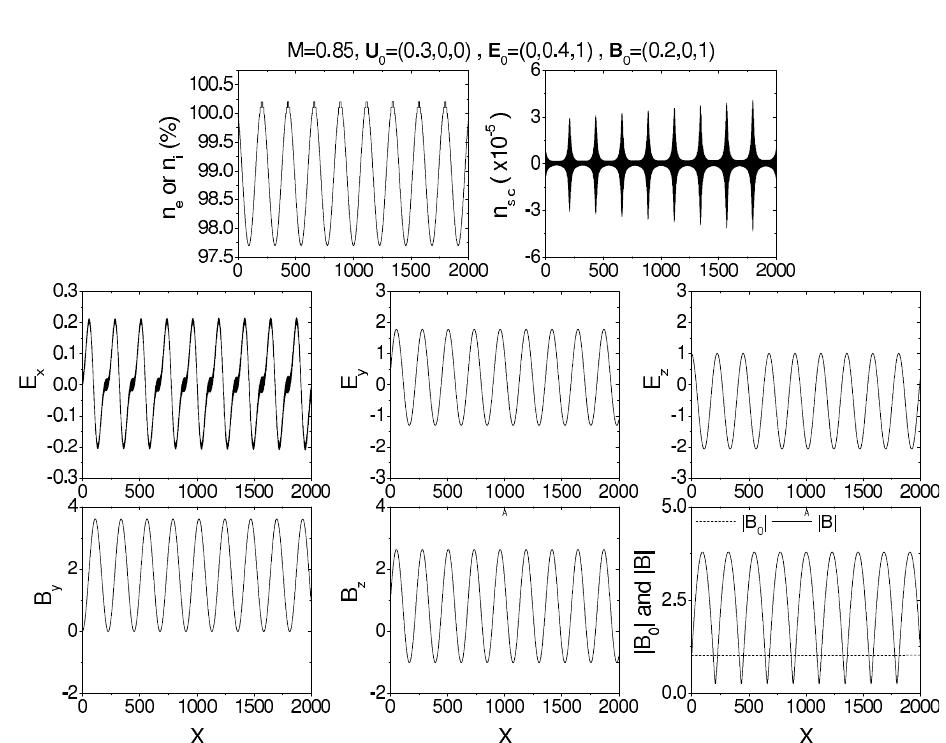
Fig. 8. Same as Fig. 4 but deformed bipolar IA/IC solitary